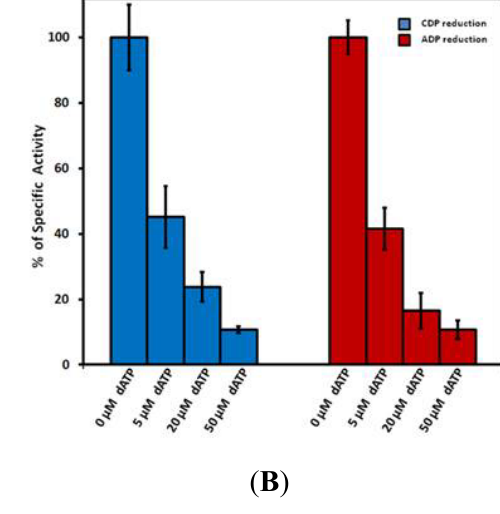
Figure 5. Characterization of dATP hexamer: ( A ) human RR1(hRR1) was tested for its ability to form hexamers in the presence of varying concentrations of dATP. No oligomers were observed in the absence of dATP (blue trace) and a mixed population of monomers, dimers, and hexamers at a dATP concentration of 5 µM (red trace). At 20 µM dATP, the hexamers are the dominant species, with a small amount of dimer (green trace). ( B ) The specific activity of the wild type enzyme decreased with increasing concentration of dATP. Activities for [1H] CDP reduction (blue) and [14C] ADP (red) reduction is shown. ( C ) Hexameric packing of RR1 based on the low-resolution X-ray crystal structure of the ScRR1 hexamer. ScRR1 monomers are colored in forest green and limon or blue and cyan. All the four-helix ATP-binding cones are colored in red. ( D ) Model of the α holo complex Reproduced with the permission from NSMB 2011